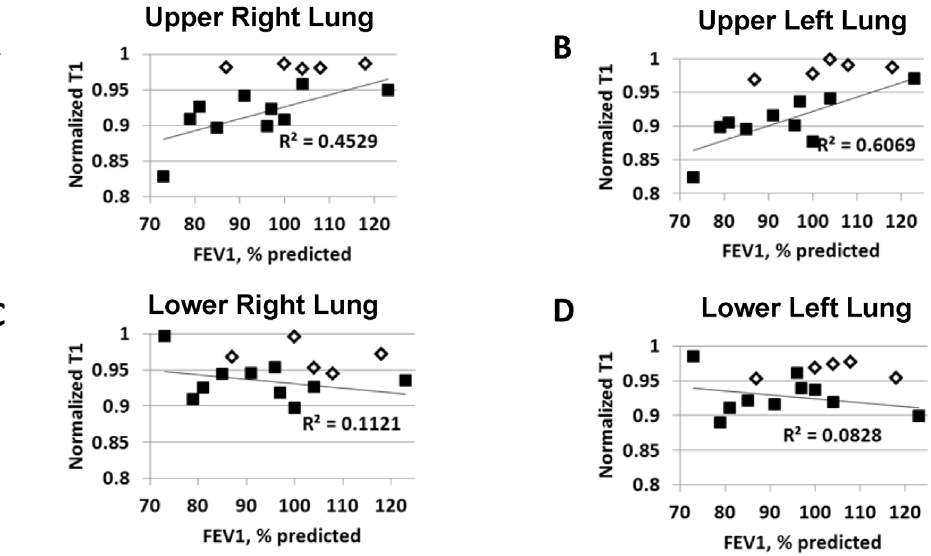
Figure 4. Mean Regional Normalized T1 Values as a Function of FEV 1 % predicted. Mean regional normalized T1 (nT1) values as a function of FEV 1 % predicted for all ten early-stage CF patients (black squares) and 5 healthy volunteers (open diamonds). (a) upper right lung region; (b) upper left lung region; (c) lower right lung region; (d) lower left lung region. Linear regression lines and Pearson Correlation coefficients for the CF patients (controls excluded) are also shown in each plot. The mean nT1 values in the upper left and right lung regions resulted in a significant linear correlation (p , 0.05) with FEV 1 % predicted despite the known variation in these spirometric results. As expected, the correlations for the mean normalized T1 assessments in the lower lung regions were not significant (p . 0.1). Note also the consistently lower mean nT1 values in the upper right and left lung regions for the CF patients in comparison to healthy volunteers.